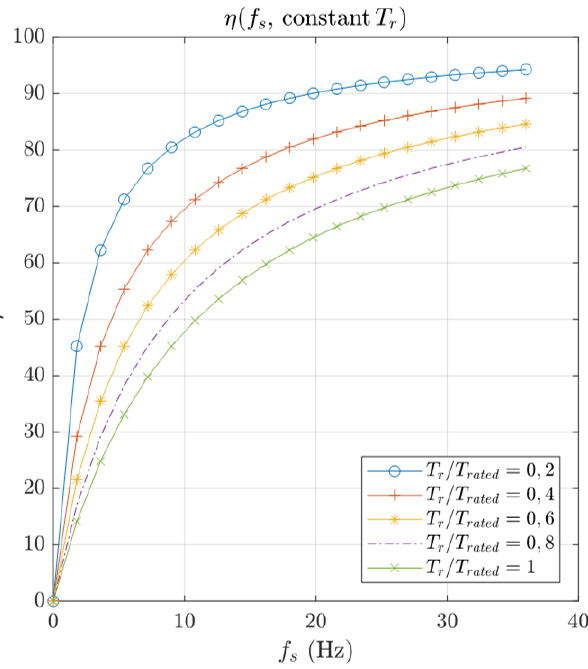
Figure 9. Efficiency–frequency curve of the Design